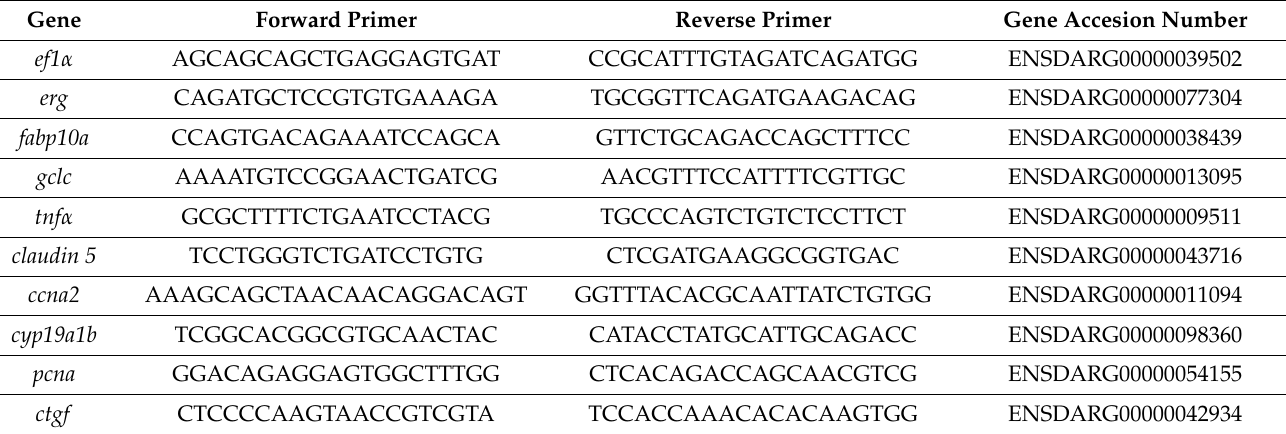
Table 1. Zebrafish qPCR primer